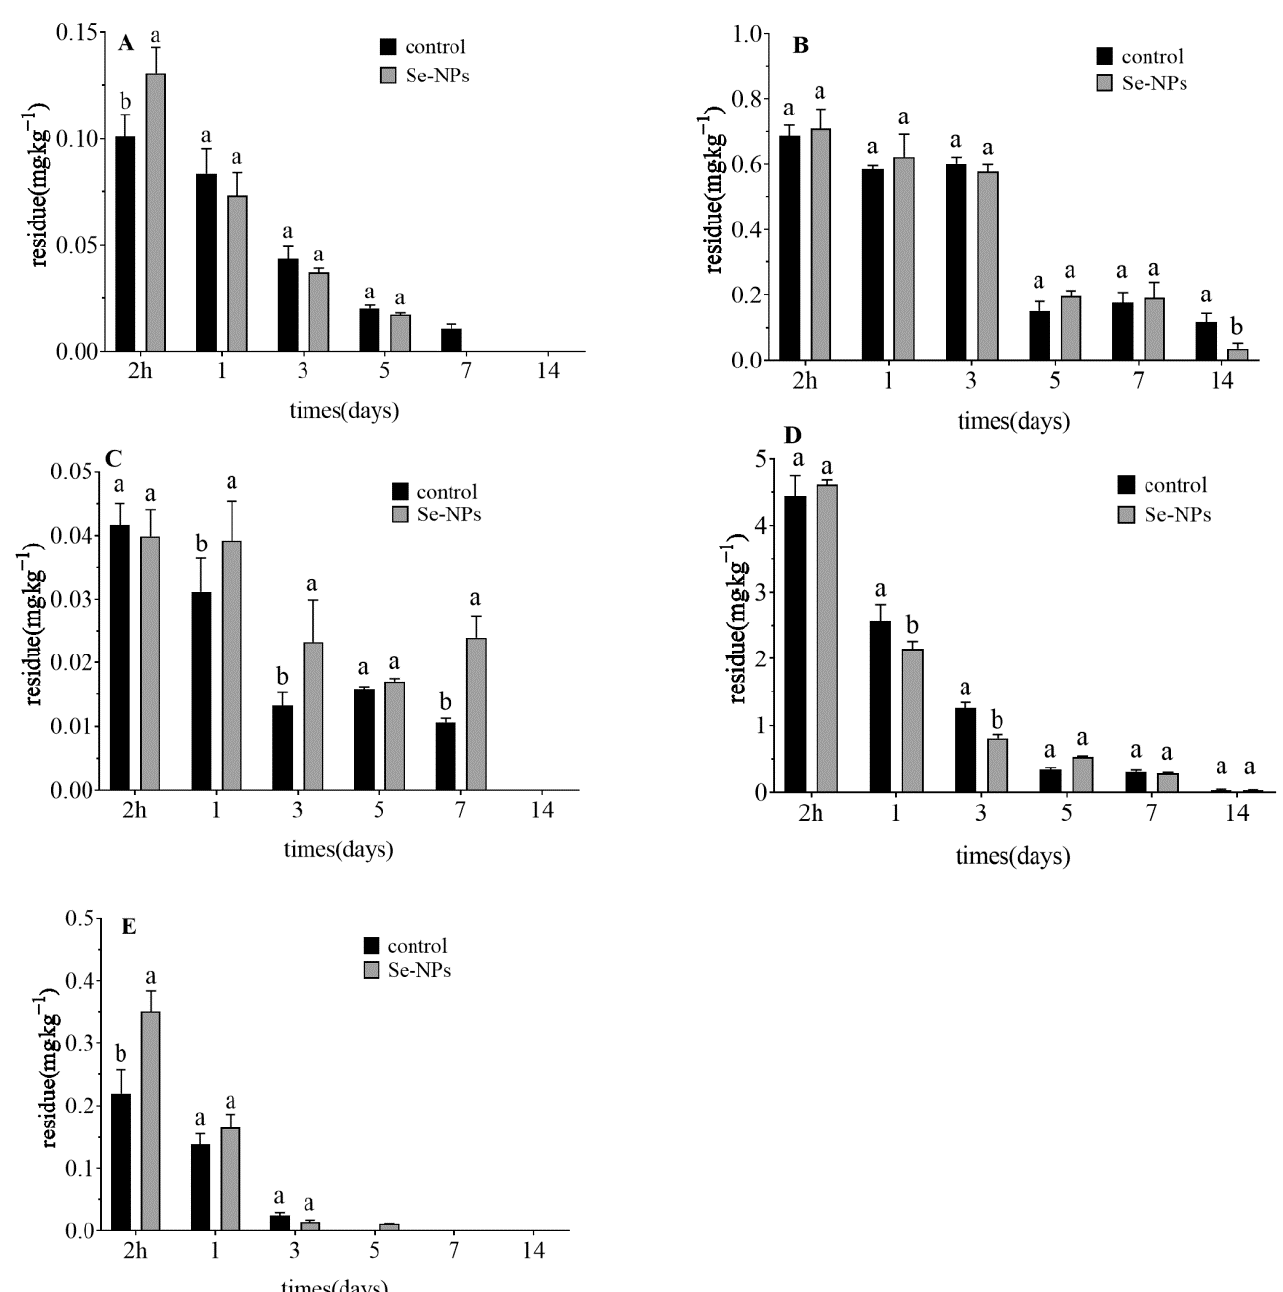
Figure 2. Dissipation rates of ( A ) thiamethoxam, ( B ) lambda-cyhalothrin, ( C ) acetamiprid, ( D ) imidacloprid and ( E ) abamectin on celery after application of pesticides at the recommended dose combined with 2 g · ha − 1 Se nanoparticles. Different letters across treatments indicate significant differences at p < 0.05.